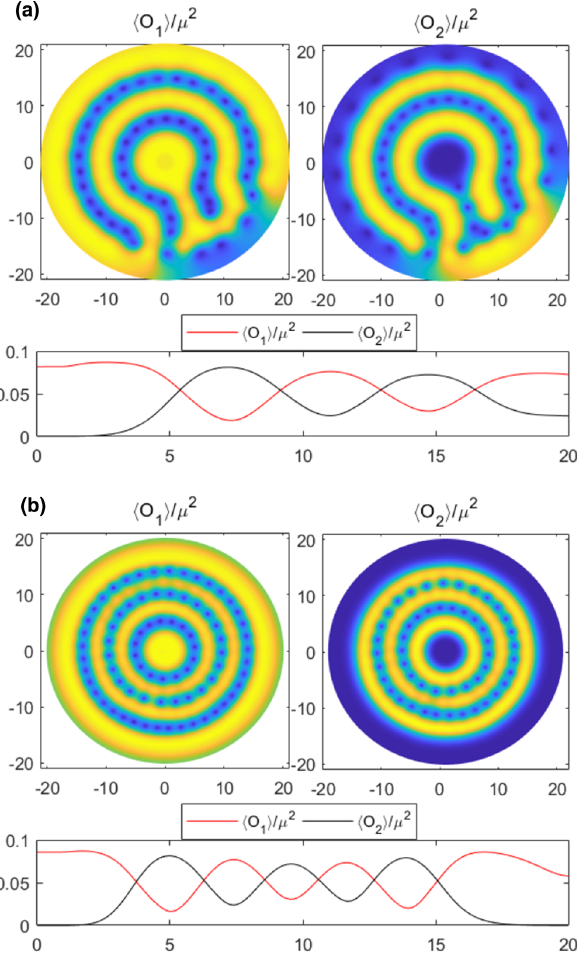
Fig. 4 Two typical perfect vortex sheet solutions and the correspond- ing radial profiles of (cid:3) O 1 , 2 (cid:4) averaged in the θ direction at T = 0 . 82 T 0 c : a η = 0 . 2 ,Ω = 0 . 15. b η = 0 . 2 ,Ω = 0 . 3